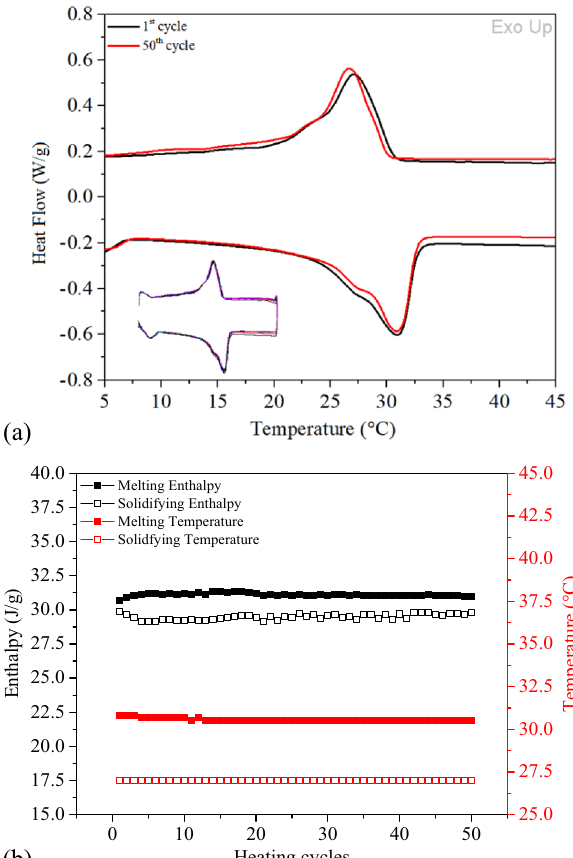
Figure 7. DSC curves of ( a ) 1st and 50th thermal cycles with the 50 consecutive thermal cycles in the inset ( b ) variations in storage and release enthalpies and thermal transition temperatures with consecutive thermal cycles for PAN-50PCM32 nanofiber mat.